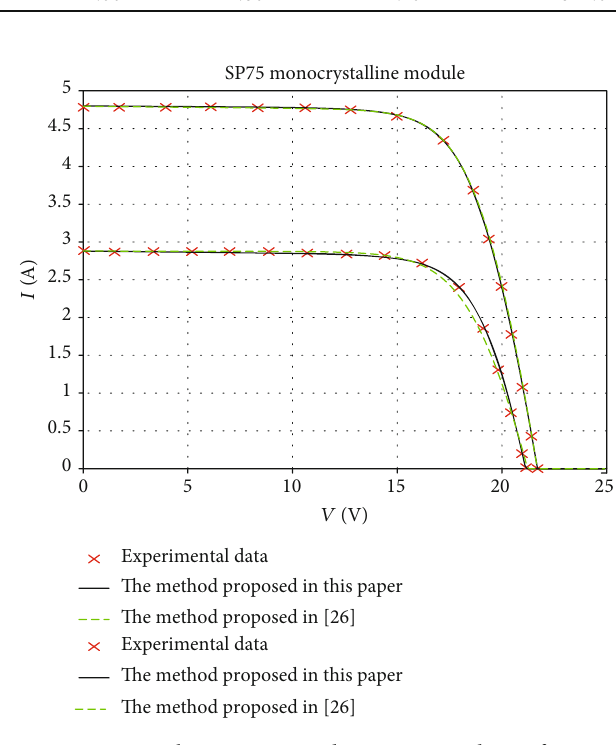
Figure 4: I – V characteristics under varying irradiance for SP75 monocrystalline module ( T = 25 °